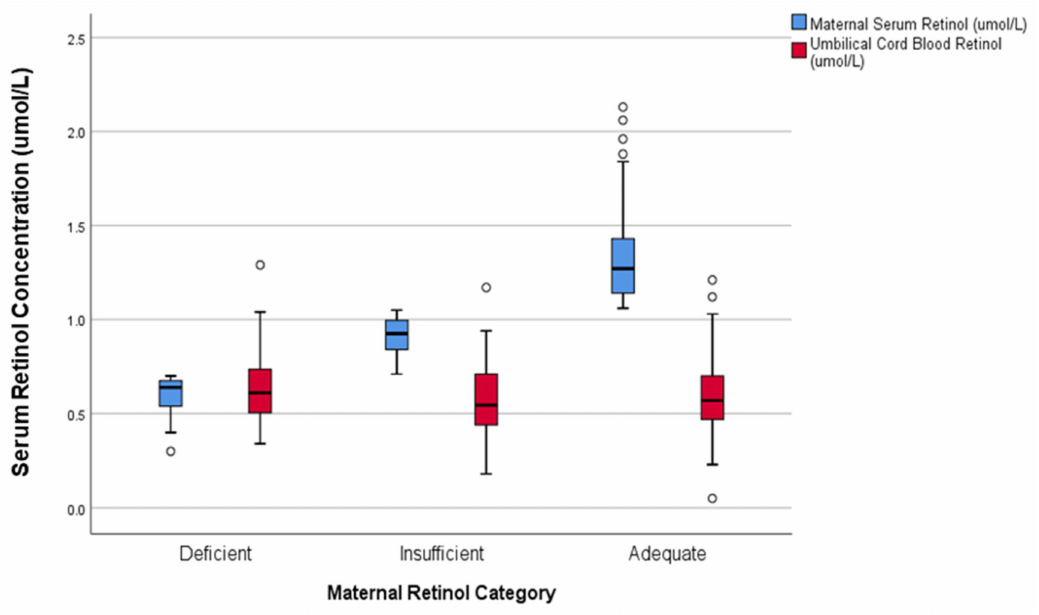
Figure 1. Comparison of maternal and infant retinol concentrations (micromoles / Liter) by maternal retinol status